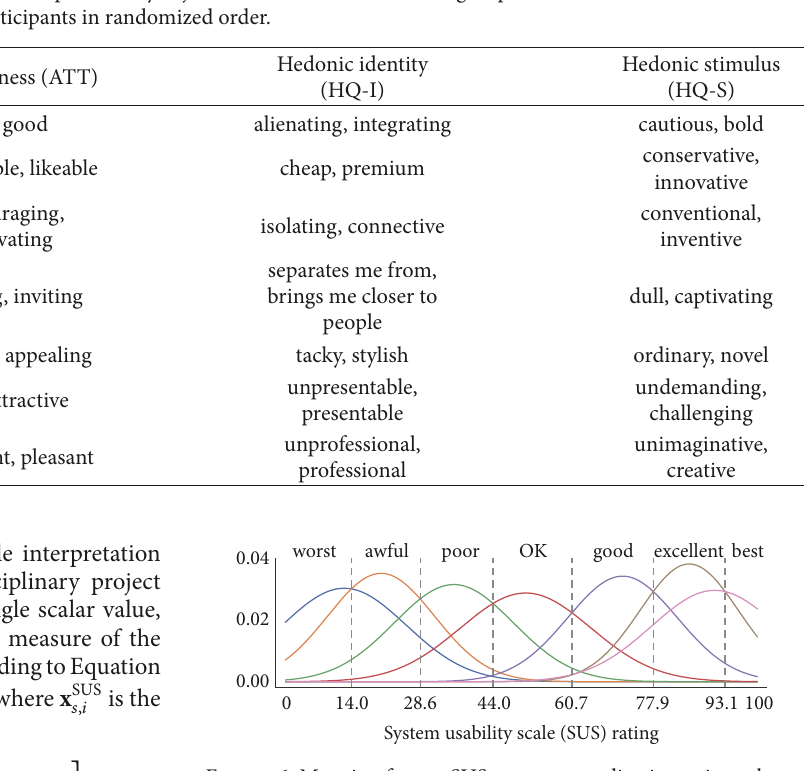
Figure 6: Mapping from a SUS score to an adjective rating scheme proposed by Bangor et al. [76]. Given a SUS rating, the relative height of the Gaussian distributions approximates the probabilities for each adjective. Distributions 𝜇 and 𝜎 were extracted evaluating 959 surveys with added adjective rating as an 11th